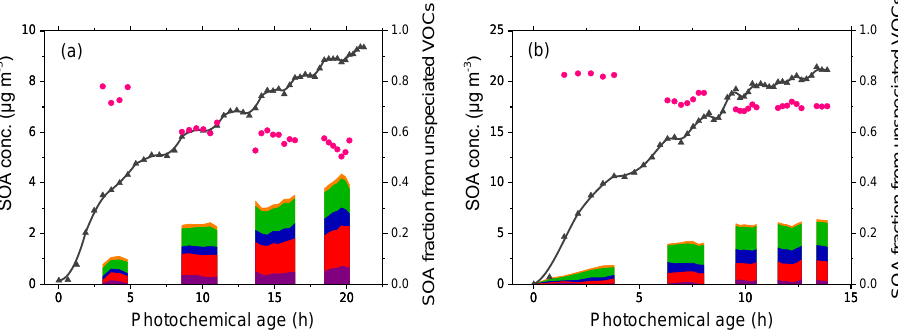
Figure 5. Observed and predicted SOA concentration as well as SOA fraction from unspeciated VOCs as a function of photochemical age in typical chamber experiments using (a) F2 (experiment V4) and (b) F3 (experiment V2) fuels. The black line and triangles represent the corrected SOA concentrations in the chamber experiments. The purple, red, blue, green and yellow areas represent the predicted SOA from the oxidation of benzene, toluene, C 8 aromatics, C 9 aromatics and styrene, respectively. The pink circles represent the SOA fractions that cannot be predicted by the one-ring aromatic VOC